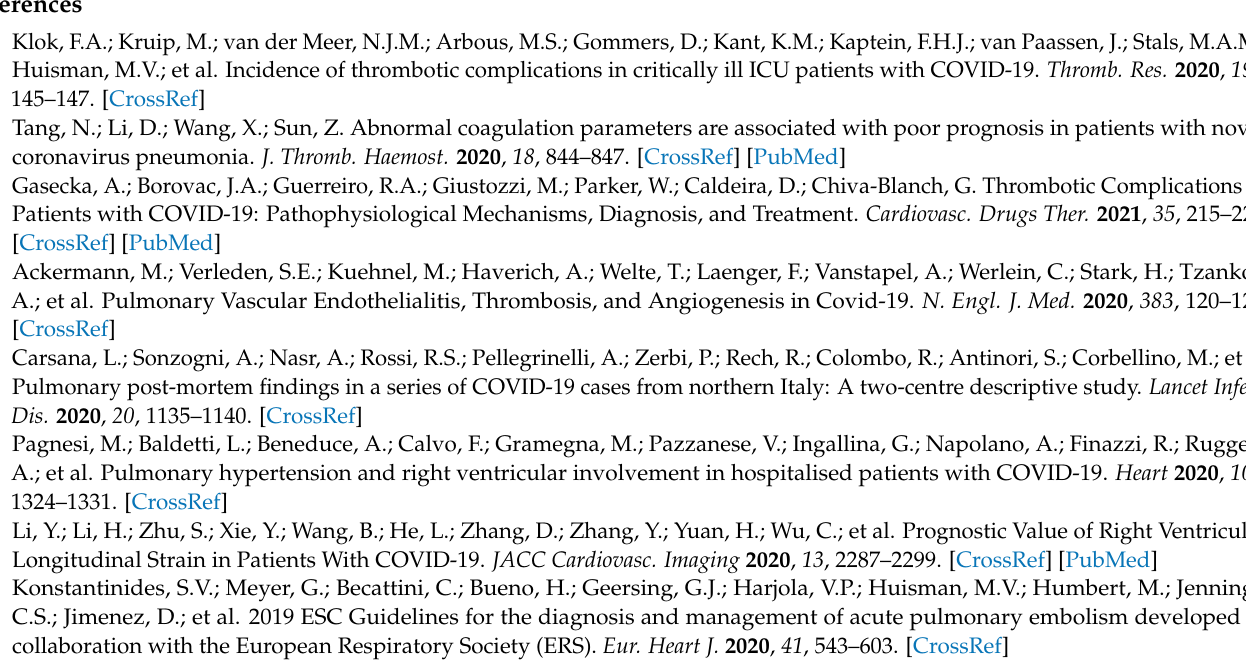
Table S1: clinical characteristics of survivor and non-survivor patients with